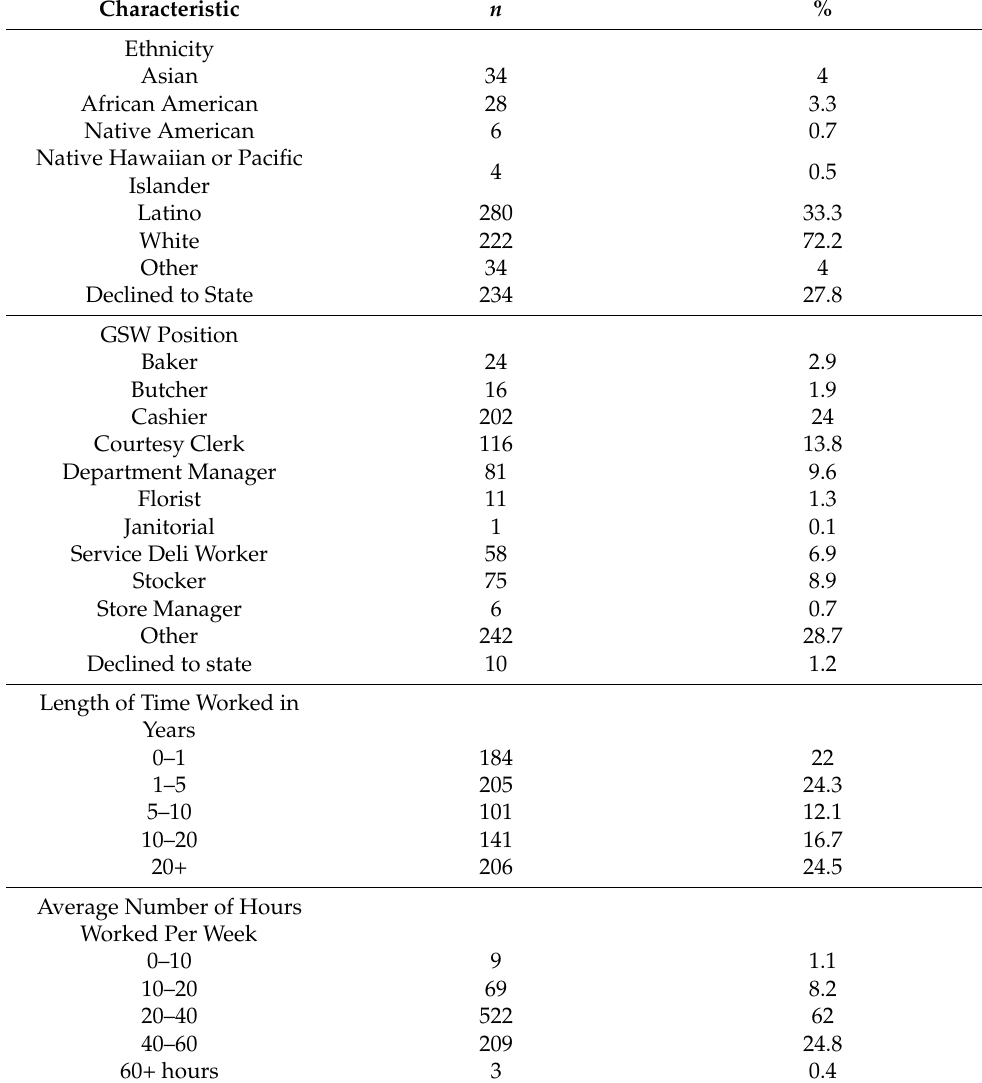
Table 1. Participant demographic and work characteristics ( n =